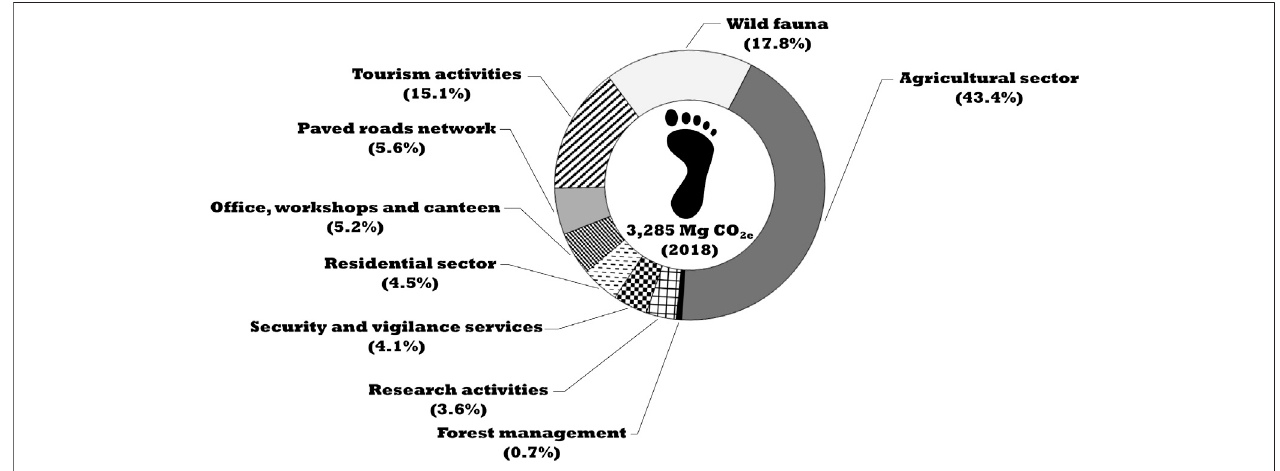
FIGURE 3 | Carbon footprint of the whole Reserve area including the incidence (%) of all sectors considered during the reporting year